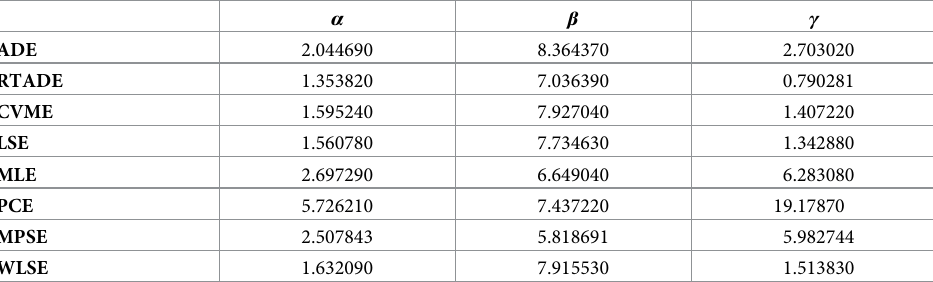
Table 4. Parameters estimation through different estimation methods for eye